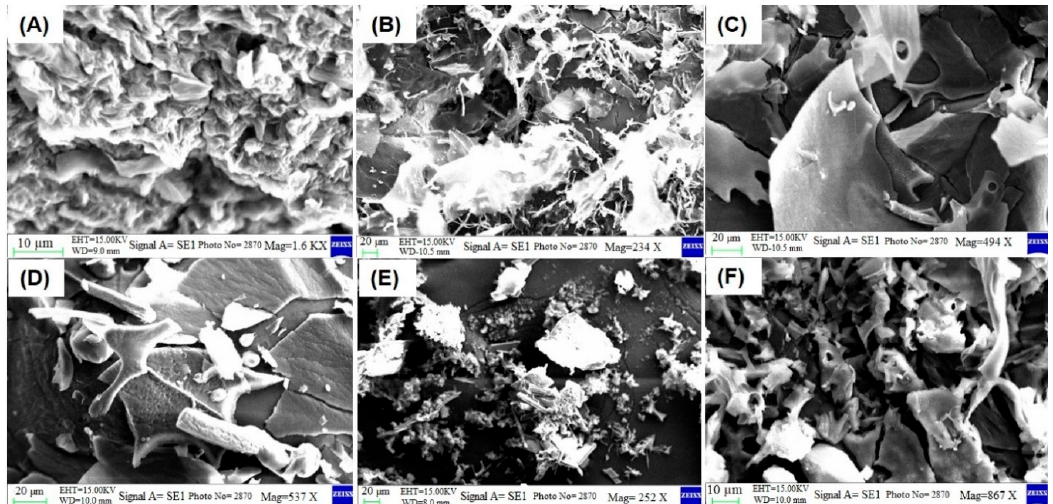
Figure 4. SEM micrographs of ( A ) GO, ( B ) NGO, ( C ) NGO-PEG, ( D ) AMP-loaded NGO-PEG, ( E ) diclofenac (DIC)-loaded NGO-PEG, and ( F ) methotrexate (MTX)-loaded